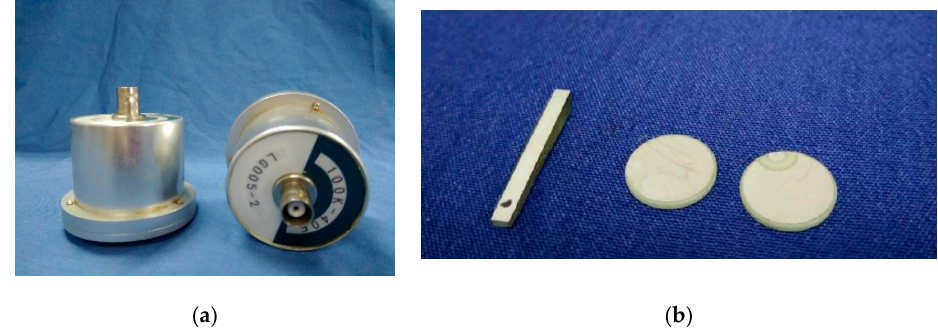
Figure 7. The transducers used in the detecting system. ( a ) Ultrasonic probe. ( b ) piezoceramic transducers.